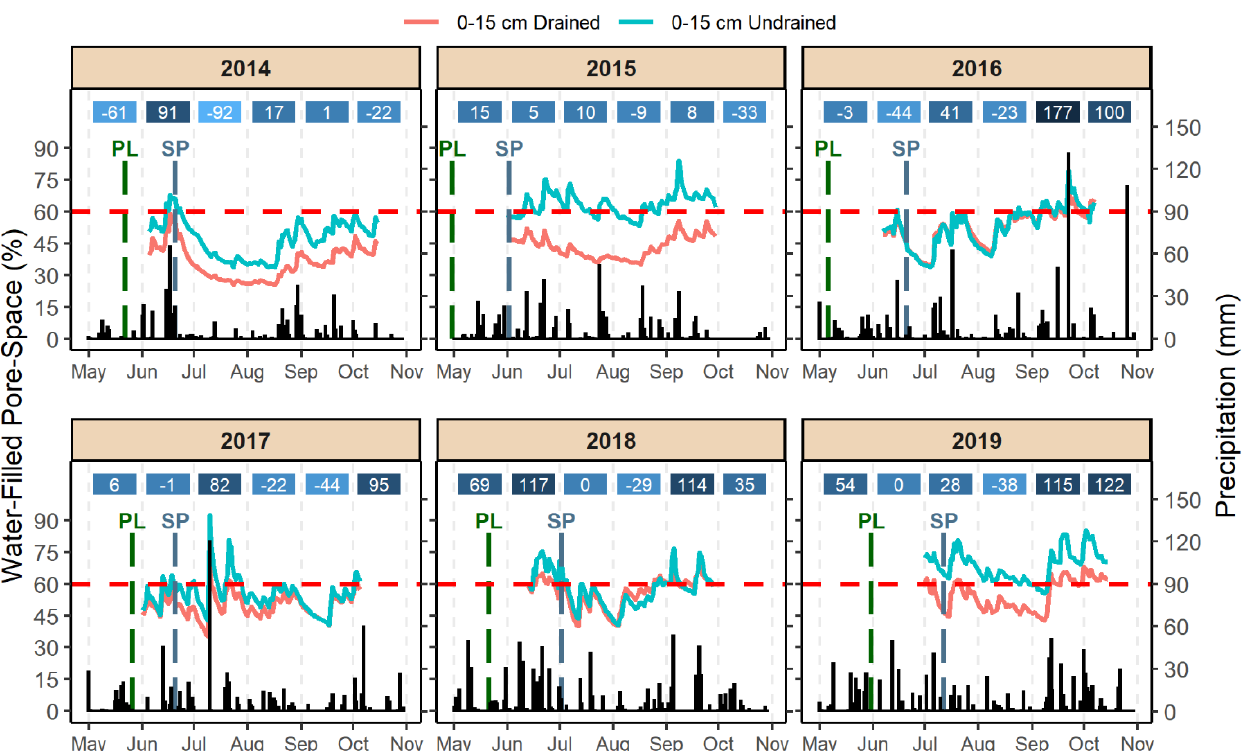
Figure 1. Daily mean water filled pore space (WFPS) at 0–15 cm soil depth for drained and undrained soils, and cumulative daily precipitation (black bars) for the 2014 to 2019 growing seasons. Red dashed lines show the WFPS at field capacity. Nitrogen fertilizer applications are noted with dashed lines, green for at-planting (PL) and grey for the split (SP). Blue-shaded boxes represent the monthly departure from normal for average precipitation (mm).